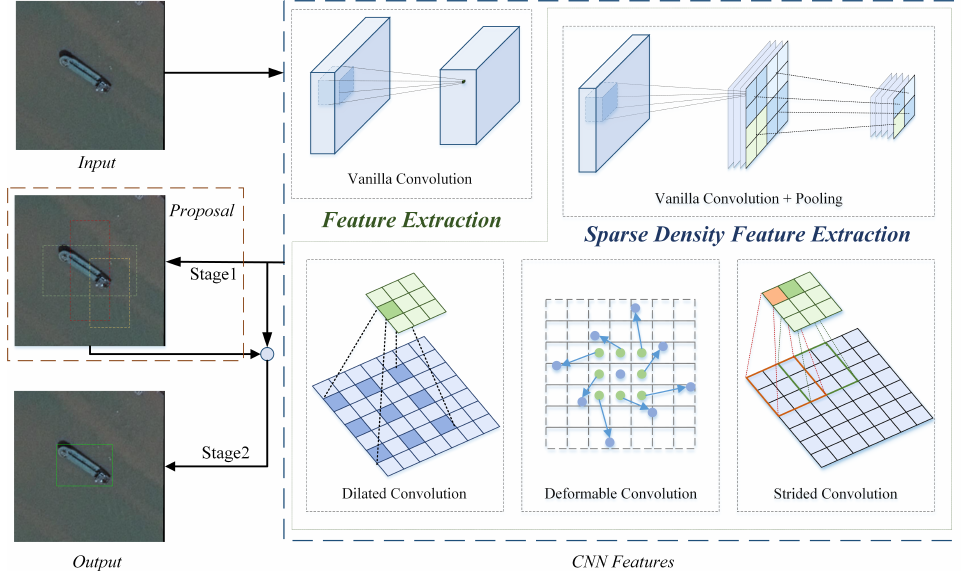
Figure 1. Typical remote sensing target detection flowchart. There are mainly two types of target detection networks, including two-stage (containing both Stage1 in the dashed box and Stage2) and one-stage networks (containing Stage2 only). For both of them, convolutional neural networks are the most common backbones for feature extraction. The vanilla convolution with the stride of one is repeatedly used in the backbone for normal density feature extraction. The sparse density feature extraction module is for receptive field enlargement and dimension reduction, concrete existing approaches of which are vanilla convolutional layer followed by a pooling layer (which is denoted as downsampling after extraction approach in this paper), dilated convolution, deformable convolution, and the most frequently used method—strided convolution,